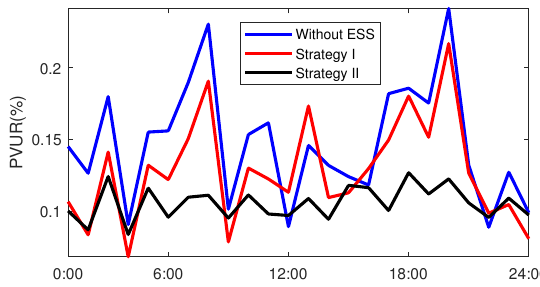
Figure 8. Maximum PVUR comparison between control strategies I and